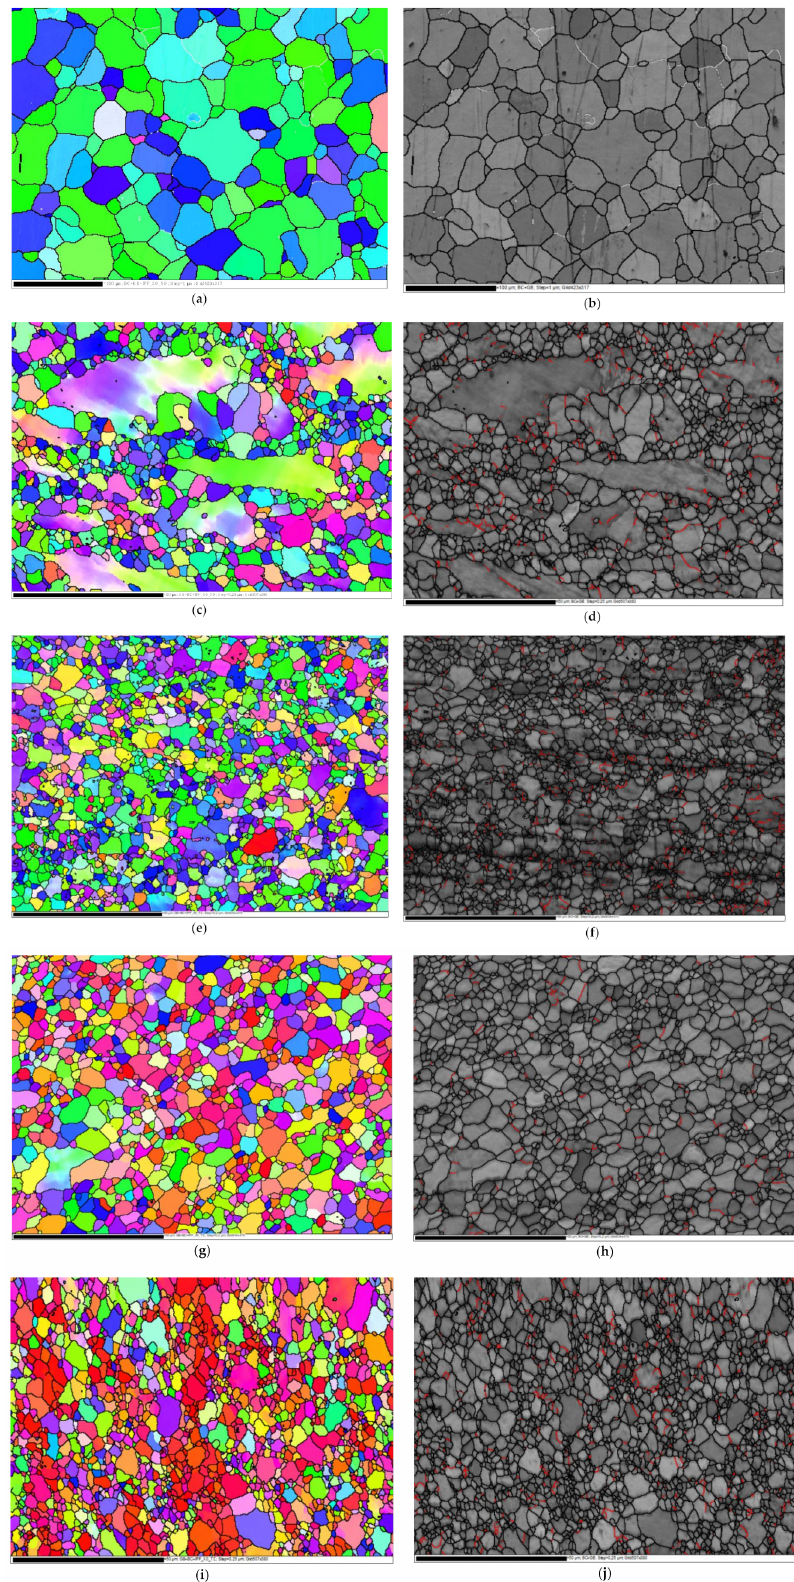
Figure 3. IPF colouring maps relative to ND and their corresponding BC maps with HAGBs in black lines and LAGBs in white lines (AA) and red lines (1-P, 4-Bc, 4-A, and 4-C), superimposed for the AA ZK30 billets ( a , b ) and ECAPed billets through ( c , d ) 1-P, ( e , f ) 4-Bc, ( g , h ) 4-A, and ( i , j )